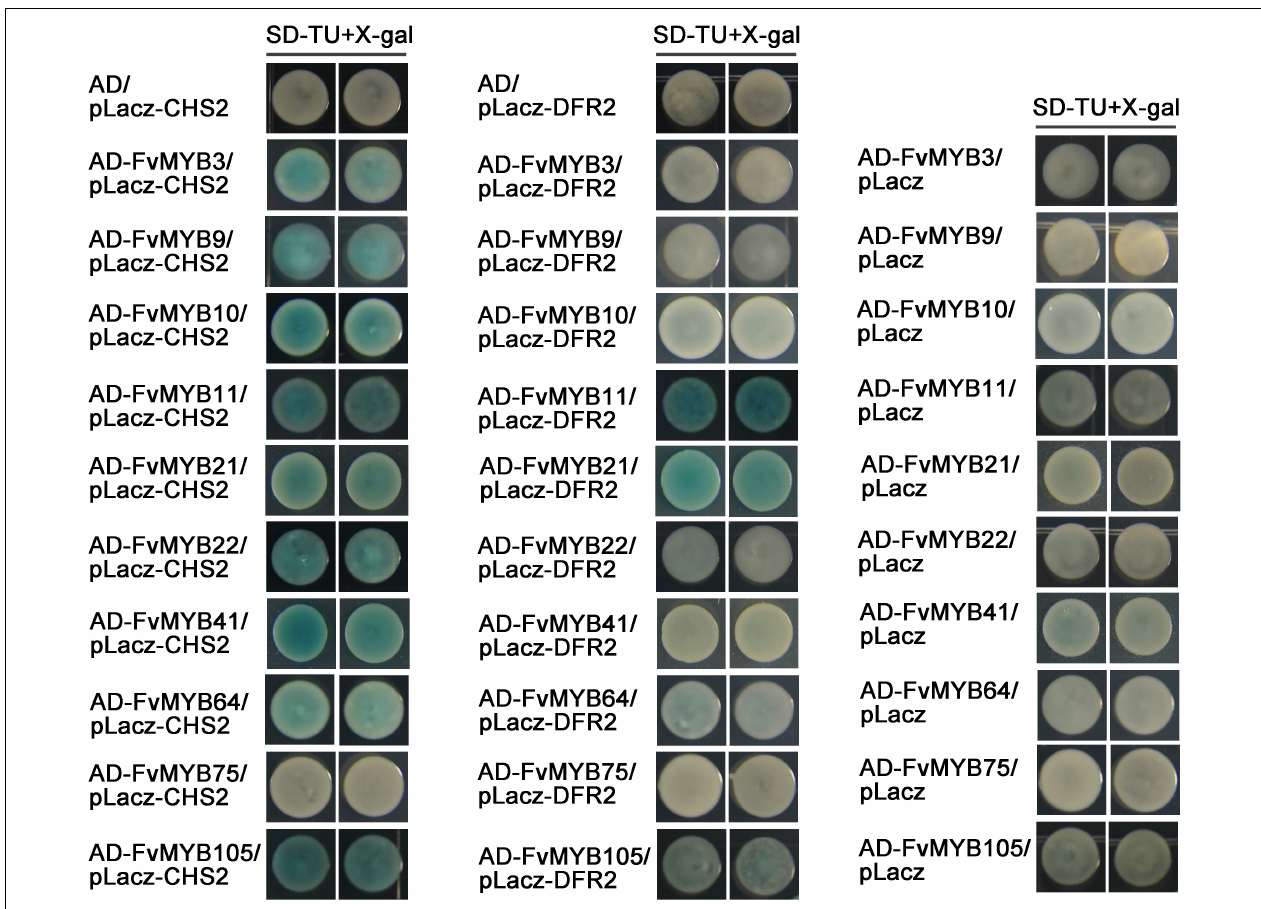
FIGURE 6 | Yeast one-hybrid assays showing the binding of MYB proteins to the promoters of CHS2 and DFR2 . Yeast cells were grown on selective medium (SD-Trp, -Ura; SD-TU) with 80 mg/L X -gal. Blue precipitates represent cumulative β -galactosidase activity resulting from the activation of the LacZ reporter gene by binding. Two representative colonies were shown for each